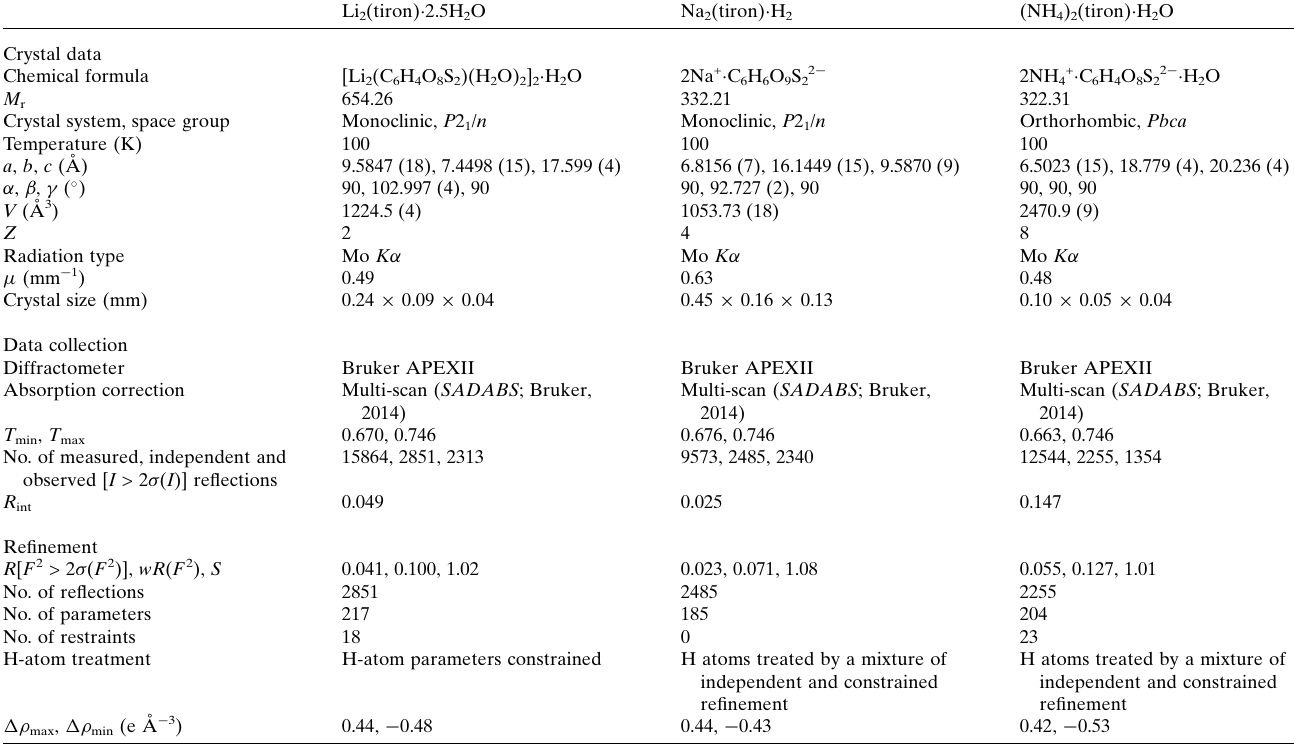
Table 6 Experimental details.